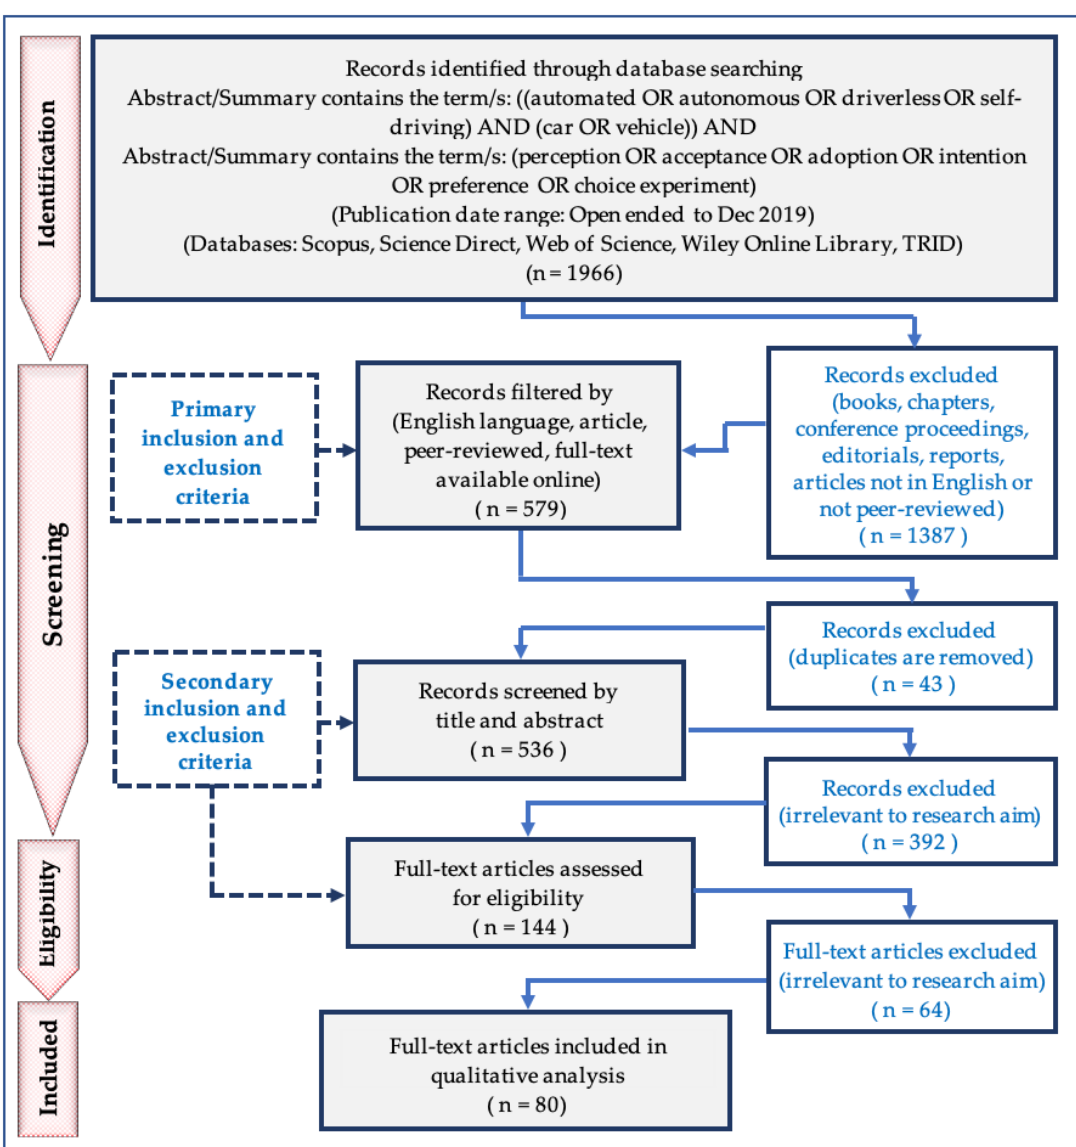
Figure 1. Literature selection procedure (Source: Authors).